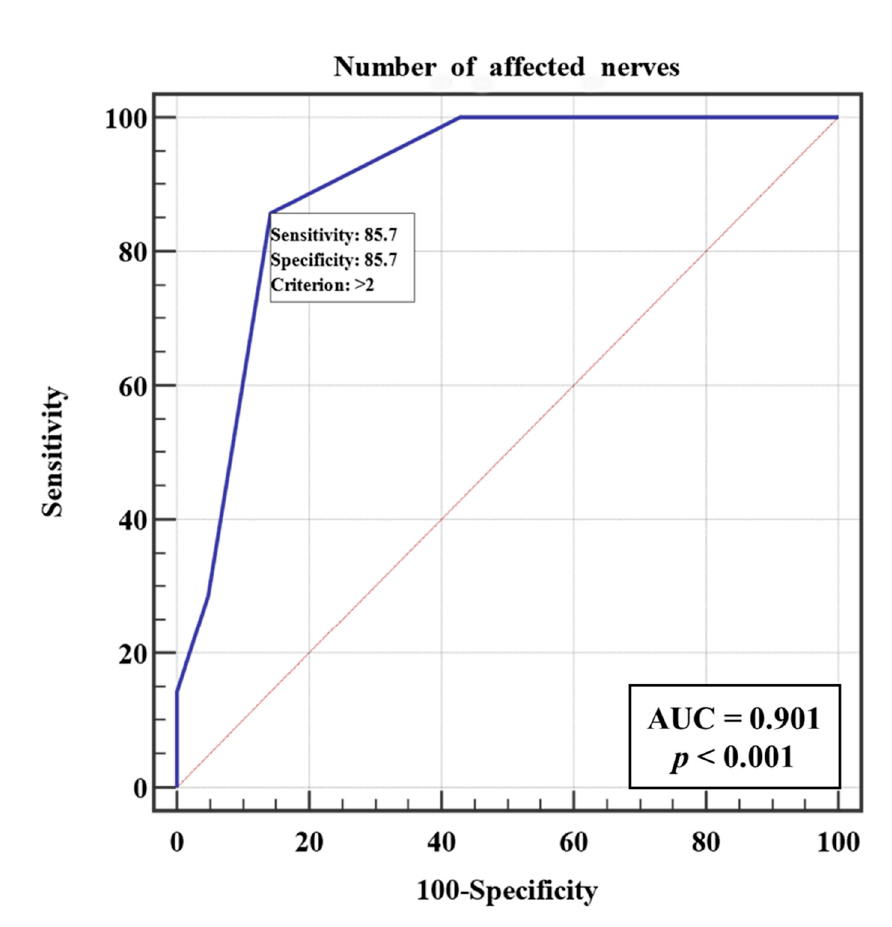
Figure 2. ROC curve for prediction of NL recurrence by number of affected nerves.